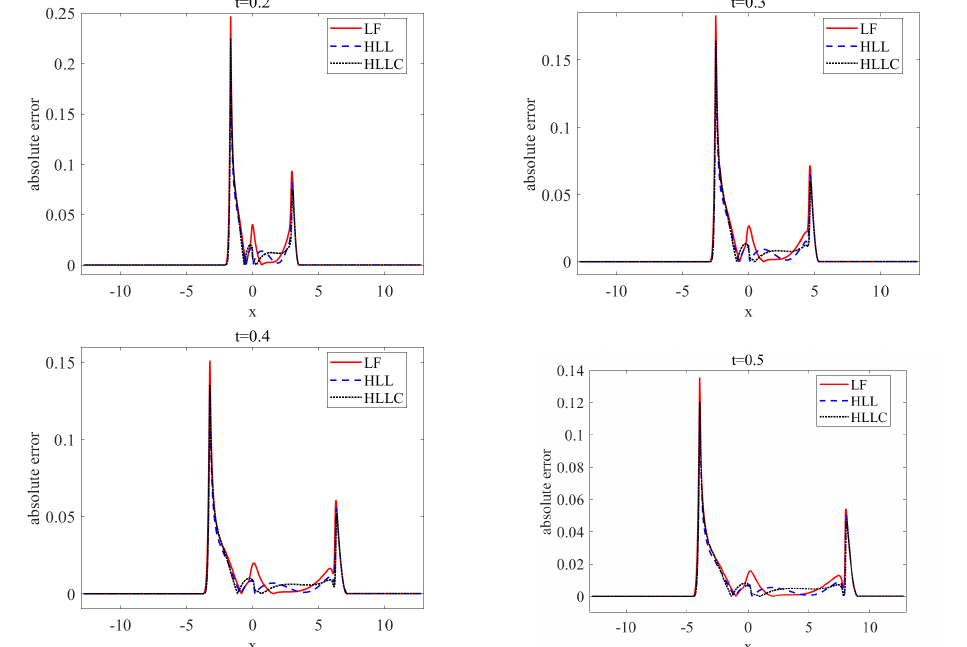
Figure 8. Pointwise absolute error of numerical solutions with WENO–LF, WENO–HLL, and WENO– HLLC fluxes along y = 0 for the 2D dam break problem at t = 0.2,0.3,0.4, and